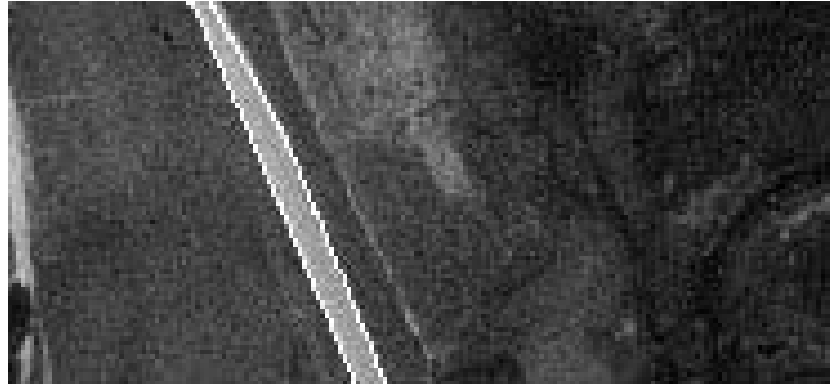
Fig. 8 – Extraction of a road seed from a real image.